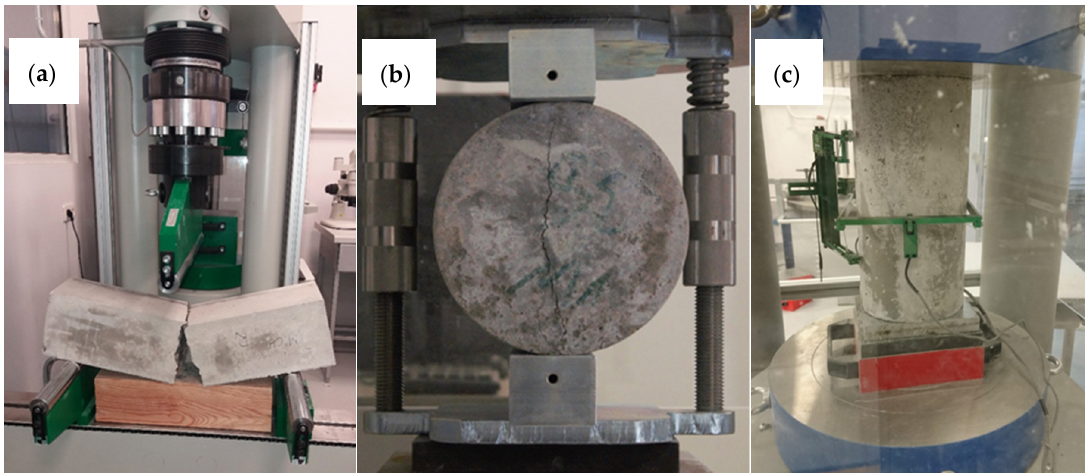
Figure 5. Photographic documentation of tests carried out: ( a ) flexural strength test, ( b ) split tensile strength test, ( c ) elastic modulus test.